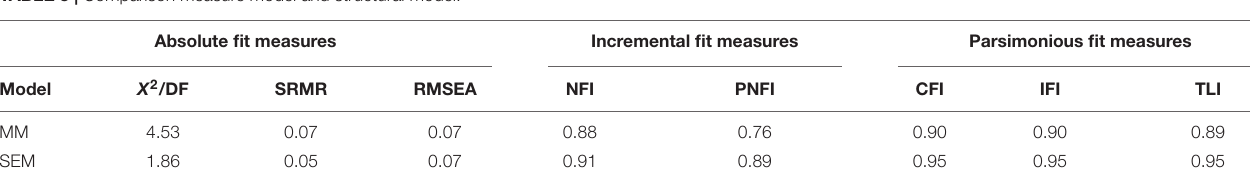
Figure 1 indicates the results of structural equation modeling of research model. Results indicated that perceived benefit ( β = 0.14, t = 2.61, p < 0.001), active learning ( β = 0.18, t =